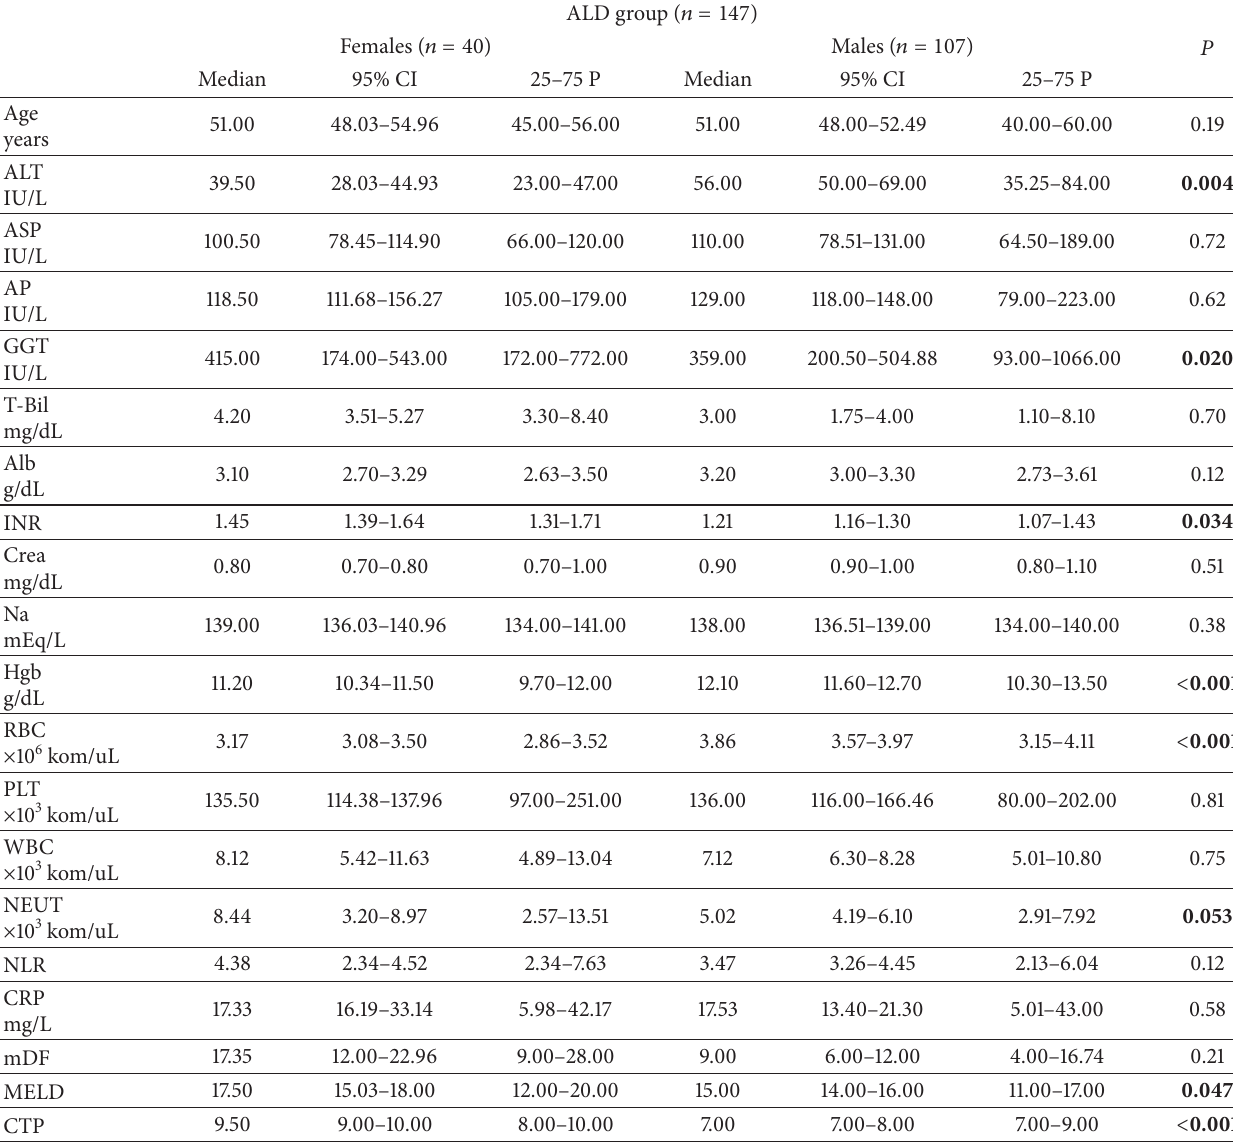
Table 1: Basic characteristics of patients with ALD based on their gender ∗